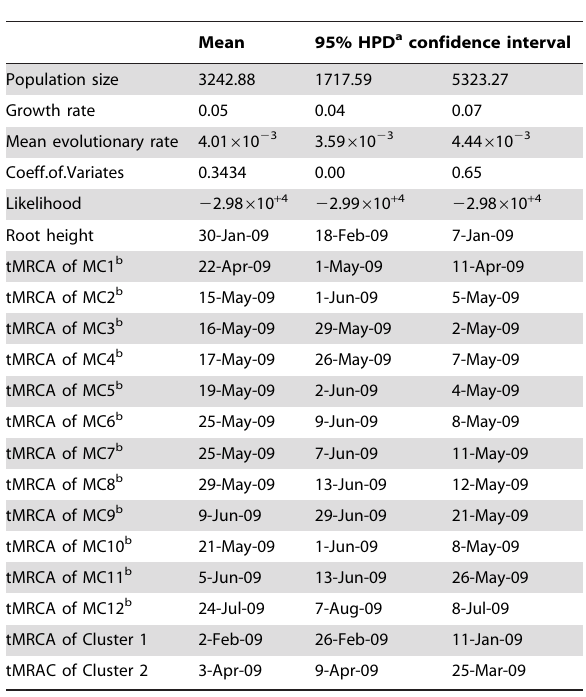
Figure 2. Bayesian coalescence phylogeny of influenza A(H1N1)pdm full-genome sequences from the world. The branch length of the phylogeny is in units of time. The scale bar indicating 30 days of the branch length is drawn at the bottom of the tree. The clusters described in the previous report [12] are annotated by brackets on the right of the tree. The sequences from Japan are colored with red. The sequences from Central- East Asia except for Japan, South-East Asia, Europe, New York, and Central-North America except for New York are colored with orange, yellow, purple, blue and green, respectively. Shadows on the terminal lineages show Japanese micro-clades. Date with arrows pointing out a node of the tree shows tMRCA of the monophyletic group. MC represents micro-clade.